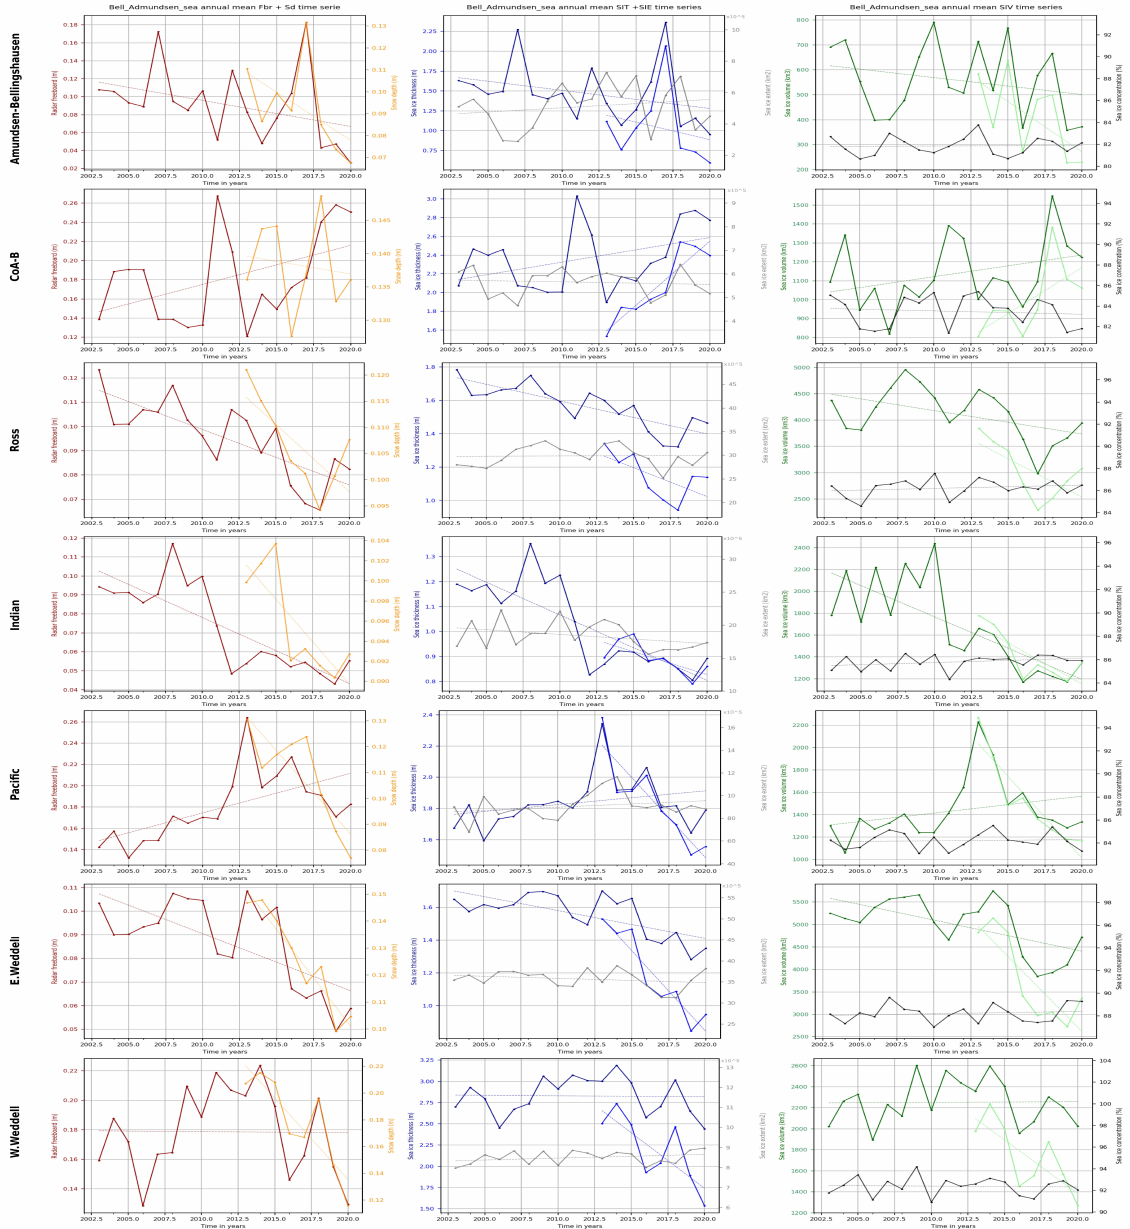
Figure A6. Same as for Figure 9 for the regions as defined in Figure